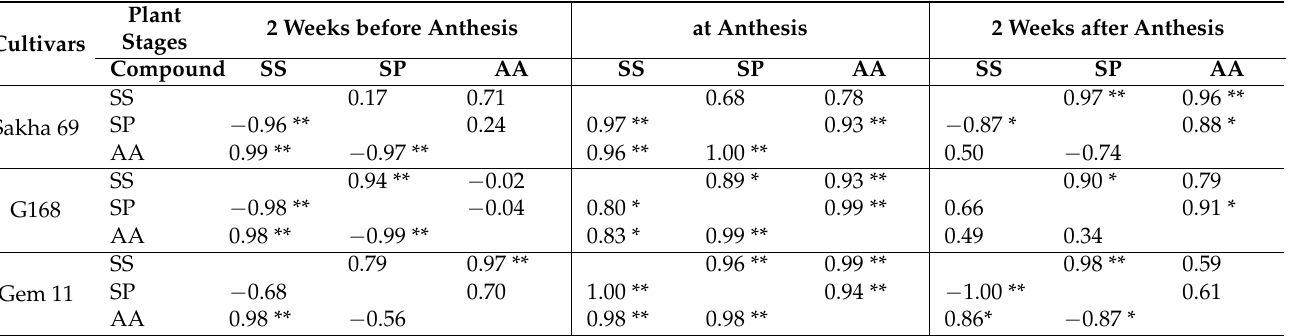
Table 4. The correlations among soluble sugars (SS), soluble proteins (SP) and free amino acids (AA) for the cultivars under drought (above) and irrigation (below diagonal) at different plant stages. at